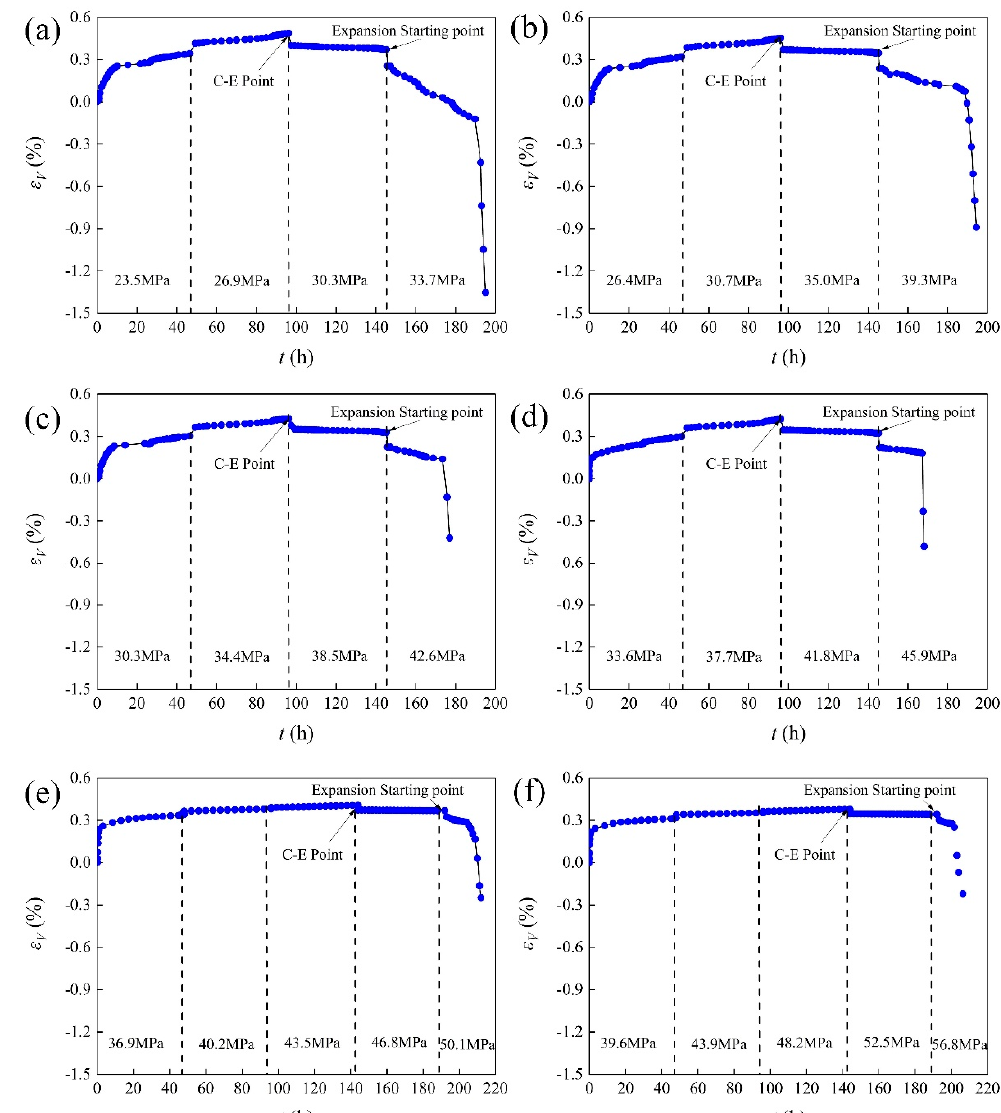
Figure 6. Volumetric strain characteristics of AS samples under di ff erent confining pressures: ( a ) 3 MPa, ( b ) 6 MPa, ( c ) 9 MPa, ( d ) 12 MPa, ( e ) 15 MPa, and ( f ) 18 MPa. (Point C-E is the compressive– expansive inflection point).